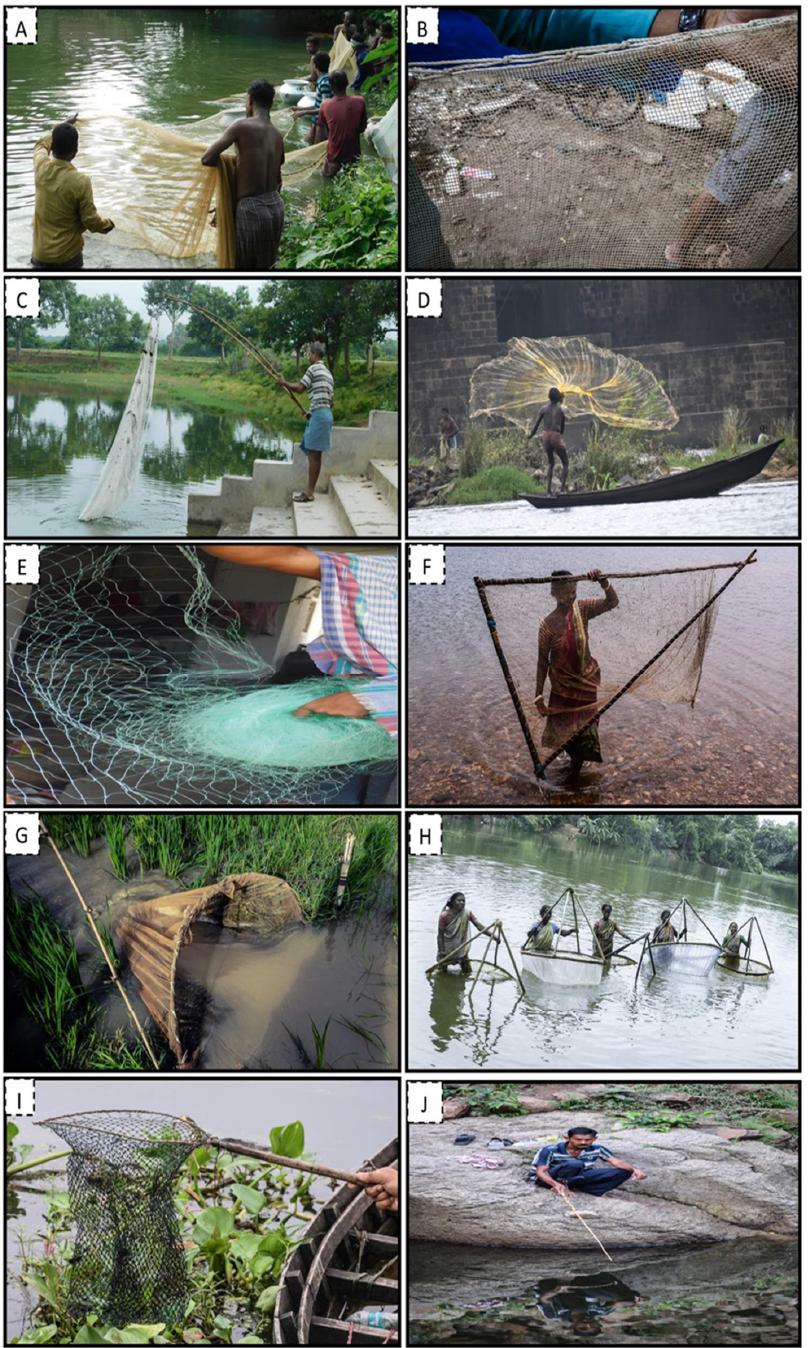
Figure 4. Traditional fishing gears: (A) Ṭ ānā jāla; (B) Ca ṭ a jāla; (C) Ghā ṭ a jāla; (D) Khi ẏ ā jāla; (E) Phām ̐ di jāla; (F) Ṭ hēlā jāla; (G) Ghu ṇ a jāla; (H) Ghuni jāla; (I) Hāta jāla; (J) Hāta